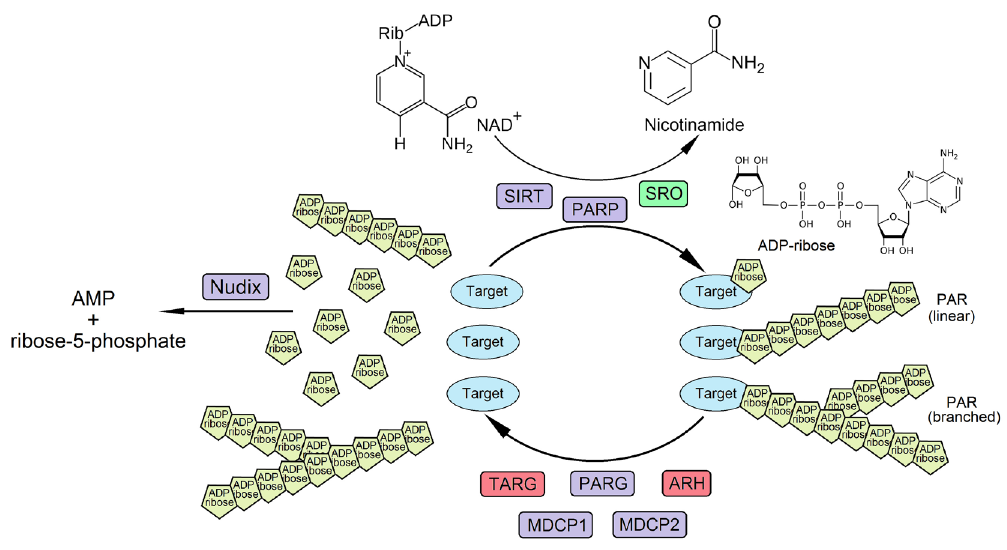
Figure 1. ADP-ribose metabolism mediated by poly (ADP-ribose) polymerases (PARP), silent information regulators (sirtuins, SIRT), SRO (Similar to RCD One), poly(ADP-ribose) glycohydrolases (PARG), ADP-ribosyl hydrolases (ARH), macrodomain-containing proteins (MDCPs), including MDCP1, MDCP2, terminal ADP-ribose protein glycohydrolases (TARG) and nucleoside diphosphate linked to some moiety-X (NUDIX) hydrolases (Nudix). Plant-specific proteins (SRO) are highlighted in green. Proteins (TARG, ARH) which were not found in plants are highlighted in red.